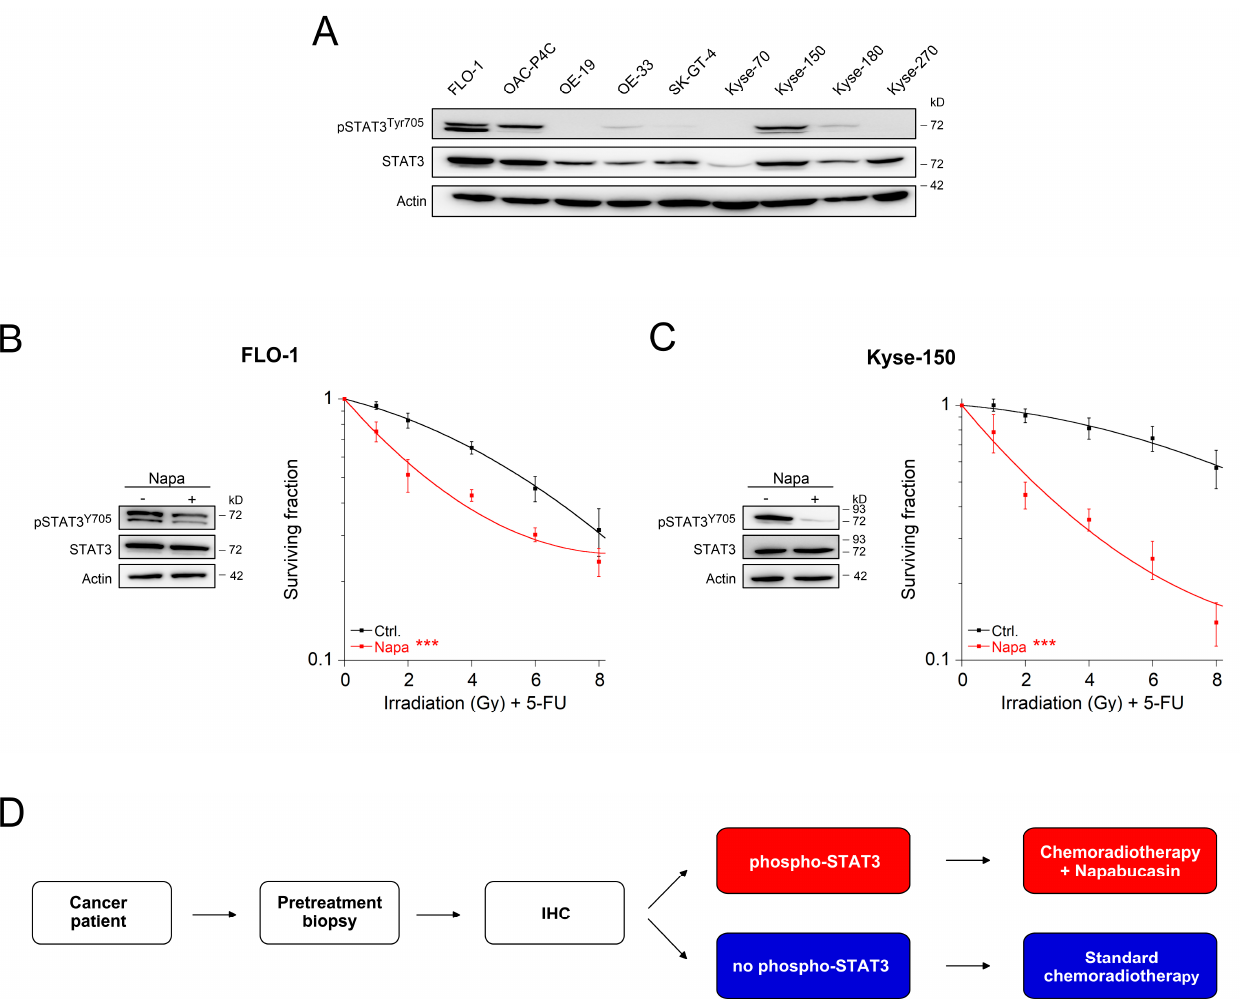
Figure 3. Targeting gp130/STAT3 signaling in esophageal cancer cells. ( A ) Nine esophageal cancer cell lines were analyzed for expression and phosphorylation of STAT3 by immunoblotting. ( B , C ) FLO-1 or Kyse-150 cells were left untreated or treated with napabucasin (Napa). Cells were either subjected to Western blot analysis (left panel), or were monitored for CFA survival after CRT (right panel). Data presented as mean ± s.e.m. from at least n = 3 independent biological replicates. *** p < 0.001, two-way analysis of variance (ANOVA). For p -values see Table S1. ( D ) Putative personalized treatment strategy for cancer patients who are referred to preoperative or definitive CRT. Pretherapeutic biopsies are tested for phospho-STAT3 via immunohistochemistry (IHC). Patients with pSTAT3-positive tumors are treated with a combination of CRT and napabucasin, while pSTAT3-negative tumors are treated with standard CRT.